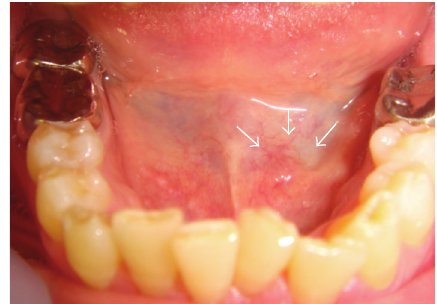
Figure 4: Clinical findings of Case 3. A small mass covered by intact normal-appearing mucosa on the right side of the floor of the